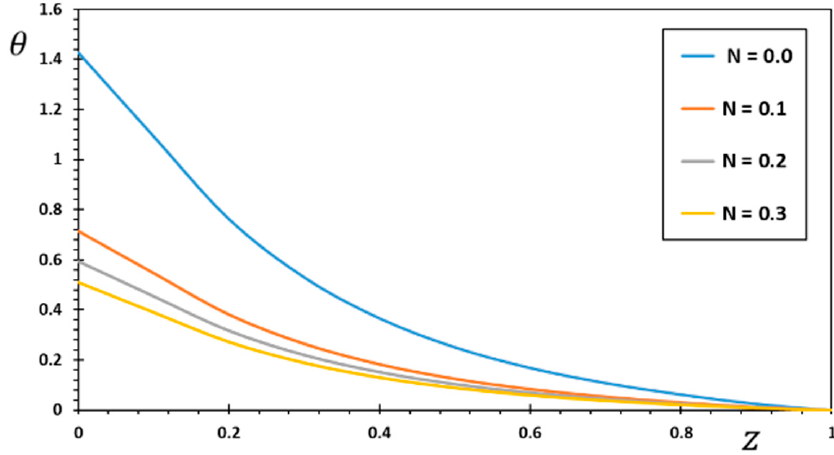
Figure 3. Variation of temperature θ for various values of the gradient coefficient N .